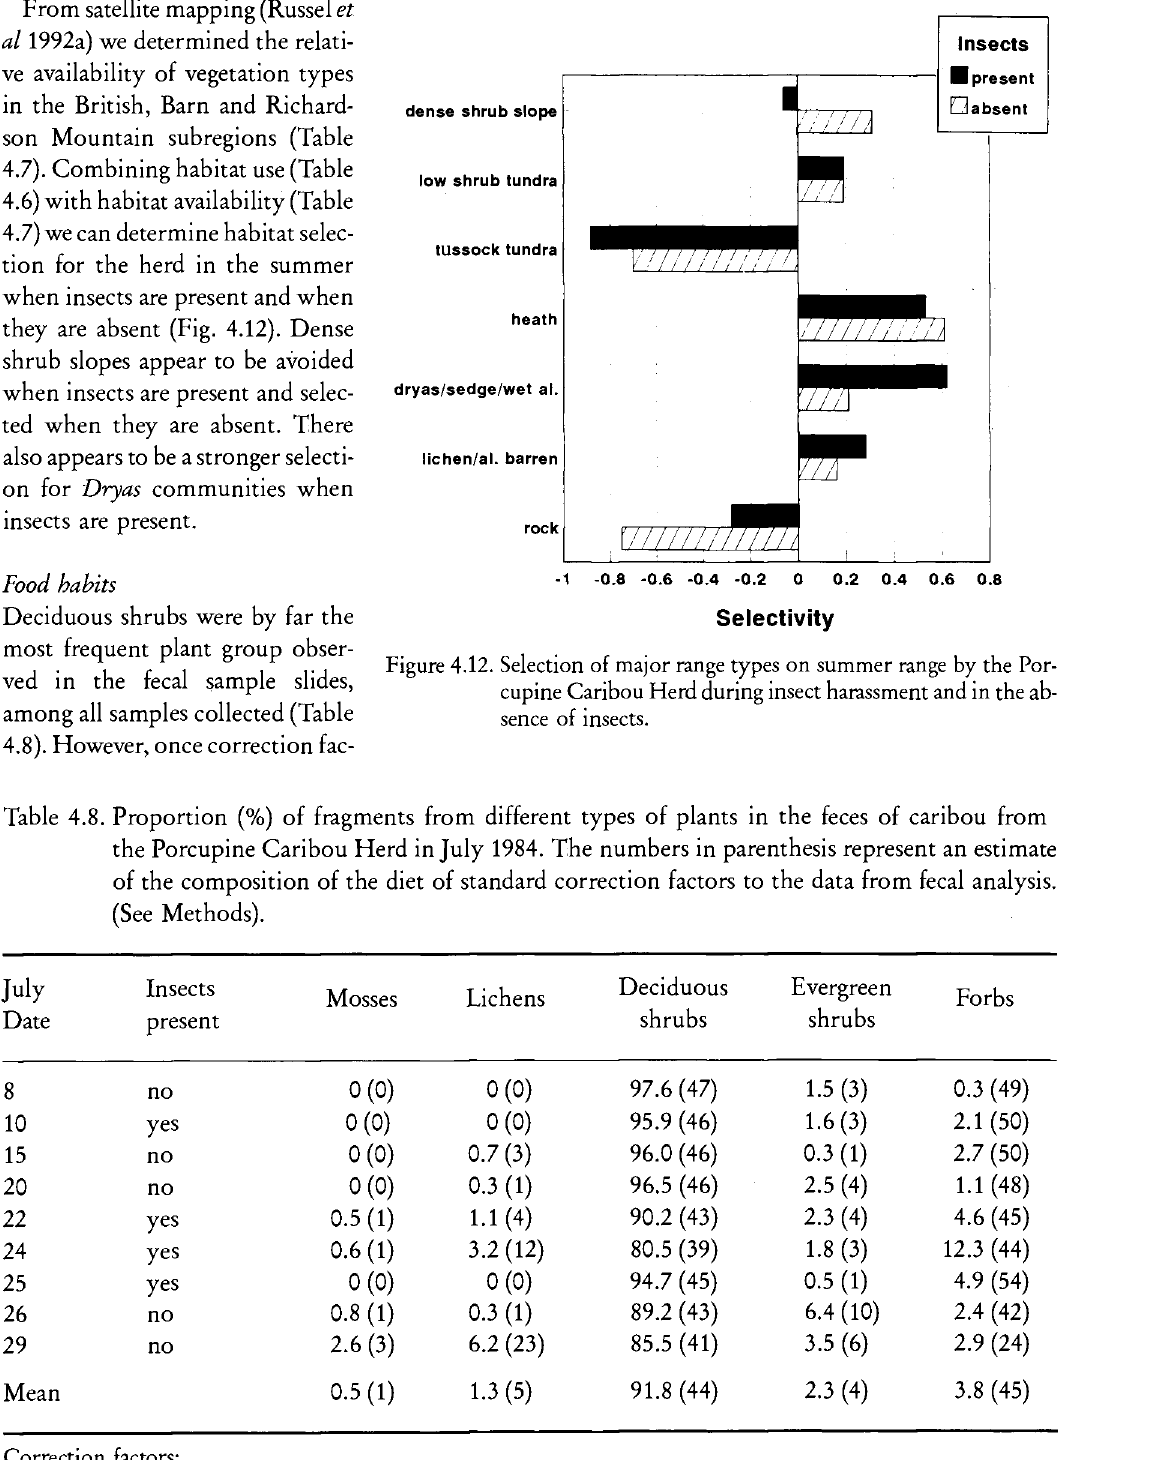
Figure 4.12. Selection of major range types on summer range by the Por cupine Caribou Herd during insect harassment and in the ab sence of